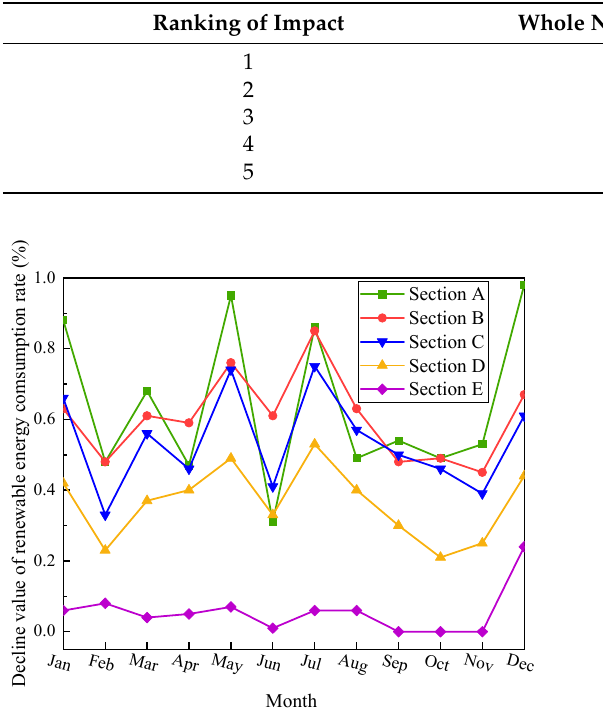
Figure 4. Decrease in the value of the renewable energy consumption rate in the whole grid.